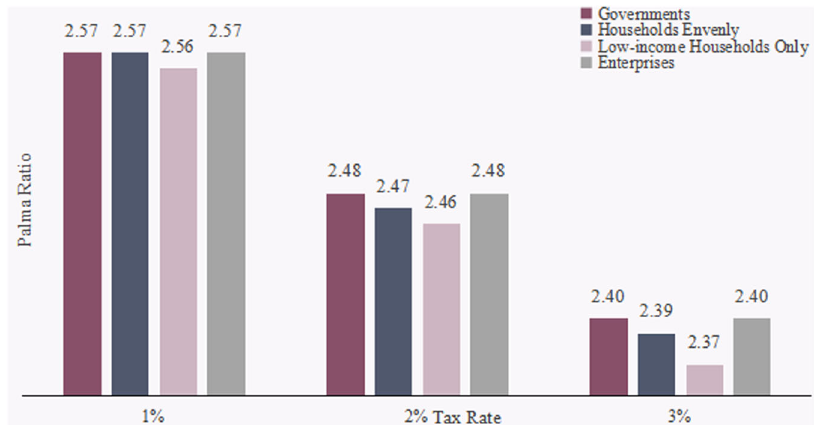
Fig. 5 Impacts of tax revenue recycling on the Palma ratio. Shows impacts of tax revenue recycling on the Palma ratio: the legends “ Governments ” , “ Households Evenly ” , “ Low-income Households Only ” , and “ Enterprises ” refer to revenue recipients are governments, entire households, low-income households, and